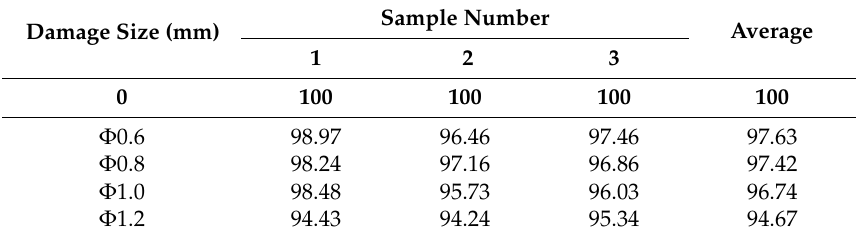
Table 4. Normalized ultrasound energy diffusion coefficient of damage category D2 (unit: %).